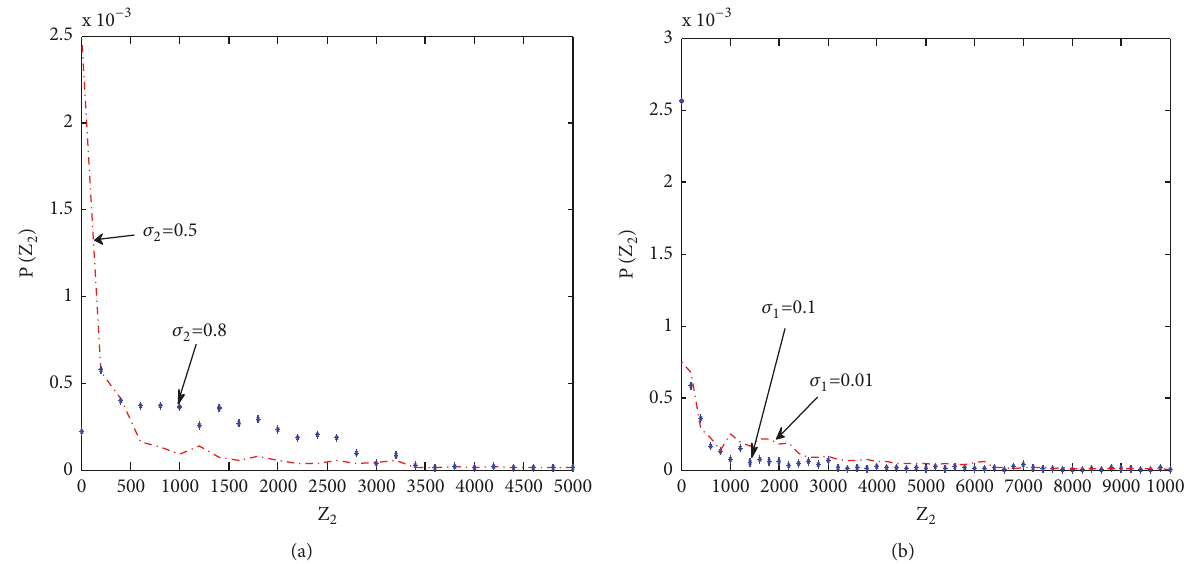
Figure 5: The stationary marginal probability density of infected target cells 𝑍 2 (𝑡) . (a) 𝜎 1 = 0.08 is fixed with 𝜎 2 = 0.5 and 𝜎 2 = 0.8 . (b) 𝜎 = 0.5 is fixed with 𝜎 = 0.1 and 𝜎 = 0.01 2 1 1